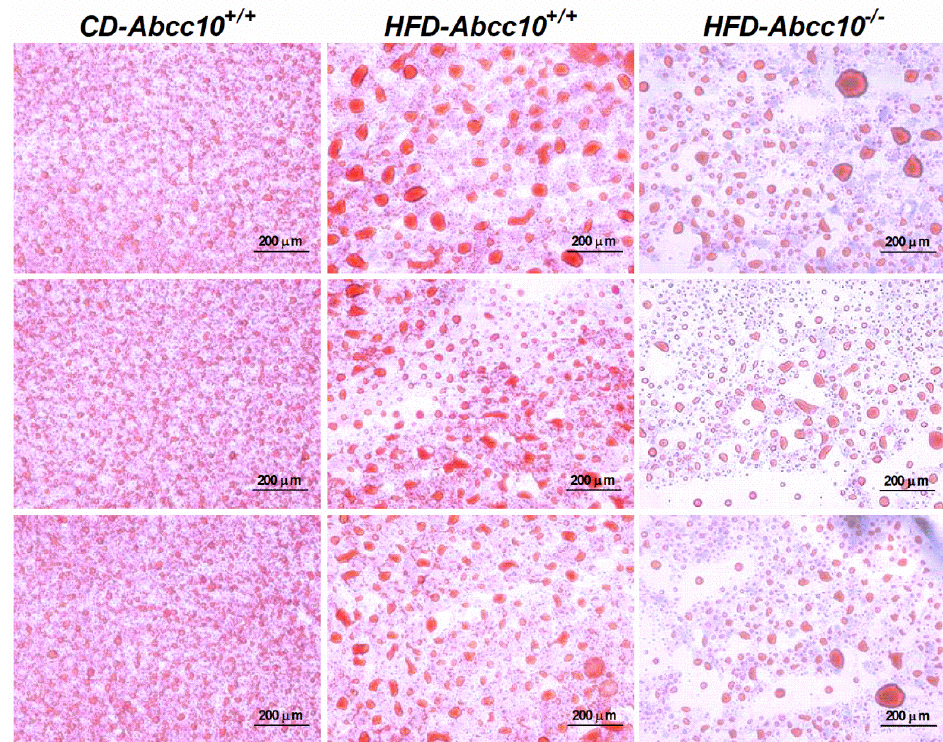
Figure 6. Deletion of Abcc10 gene reduces accumulation of lipids in high-fat-diet-fed mice. Eight-week-old Abcc10 +/+ ( HFD-Abcc10 +/+ , n = 4) and Abcc10 − / − ( HFD-Abcc10 − / − , n = 5) male mice were fed high-fat obesity diet for 16 weeks. As a control, age-matched Abcc10 +/+ ( CD-Abcc10 +/+ , n = 4) male mice were kept on chow diet during this period. At the end of the experiment, mice were fasted overnight and sacrificed. Oil Red O staining for lipid droplets in liver tissue sections from these mice was performed and representative pictographs (10×) from each group are shown in the figure.